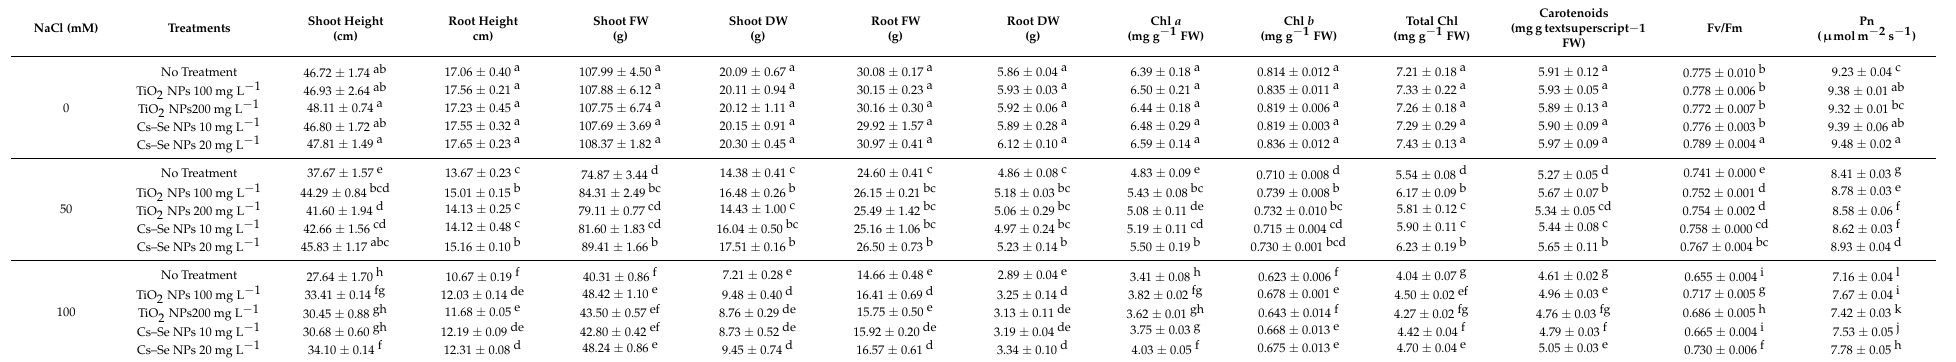
Data are the average of 3 repetitions ± standard error. Different letters in a column indicate significantly different values according to Duncan’s post hoc analysis at p <